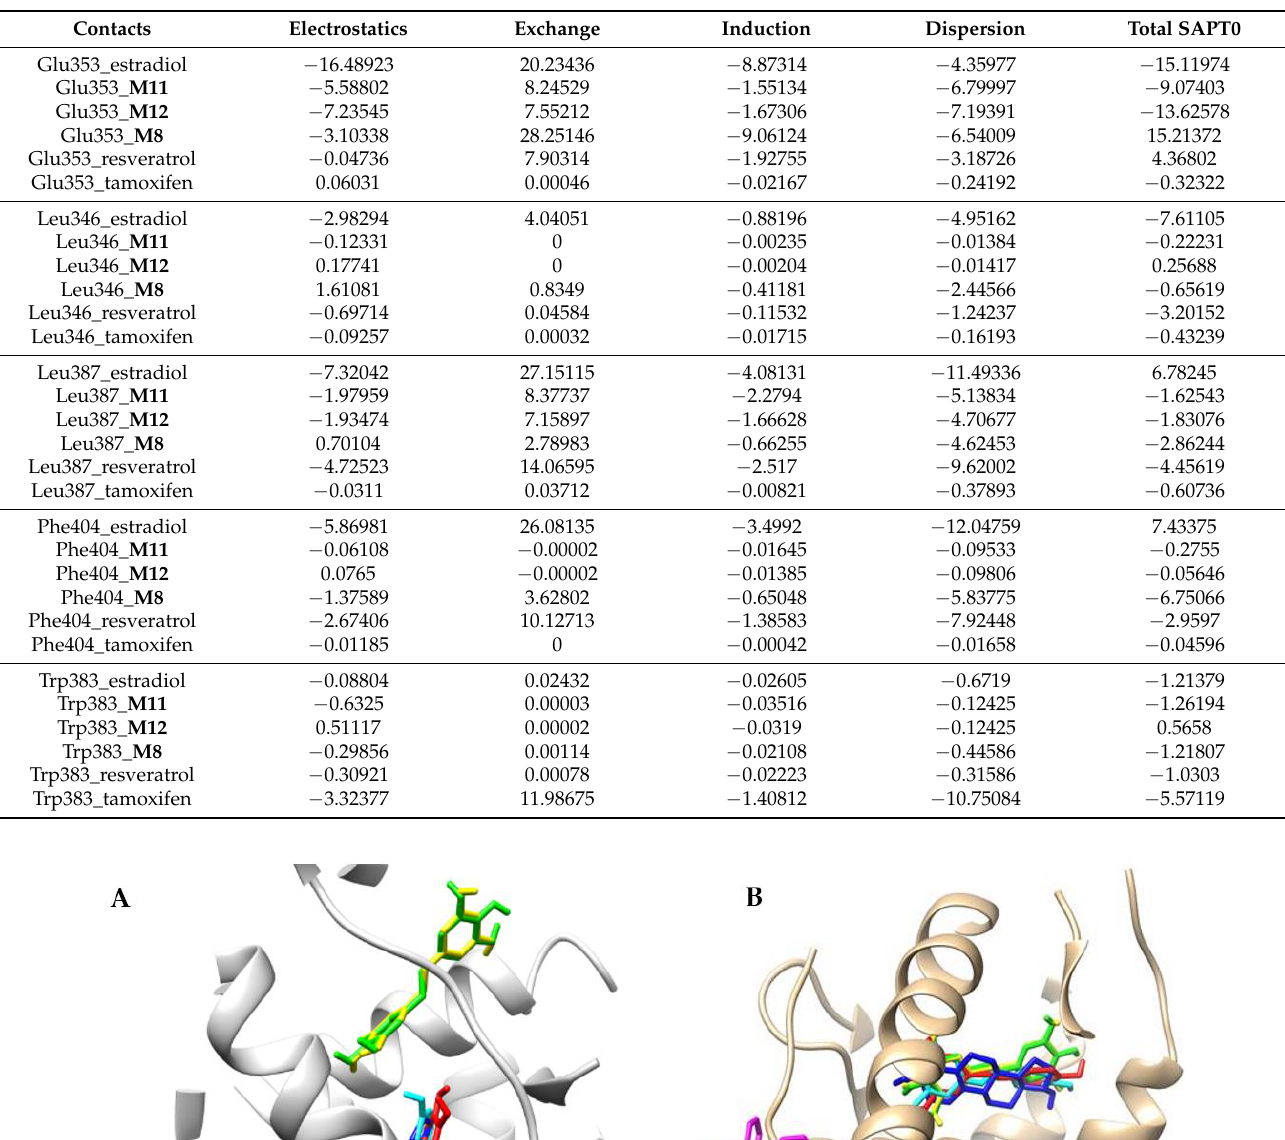
Table 3. ER α calculated total values of the interaction ligand amino acid energy (kcal/mol) using the SAPT0 method for docked ligands.